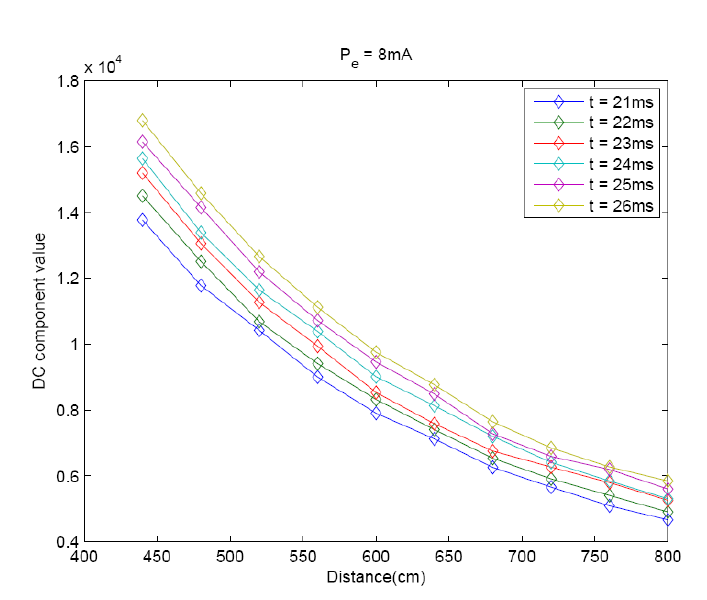
Figure 5. Behavior of the DC component in relation to the distance between the IRED and the